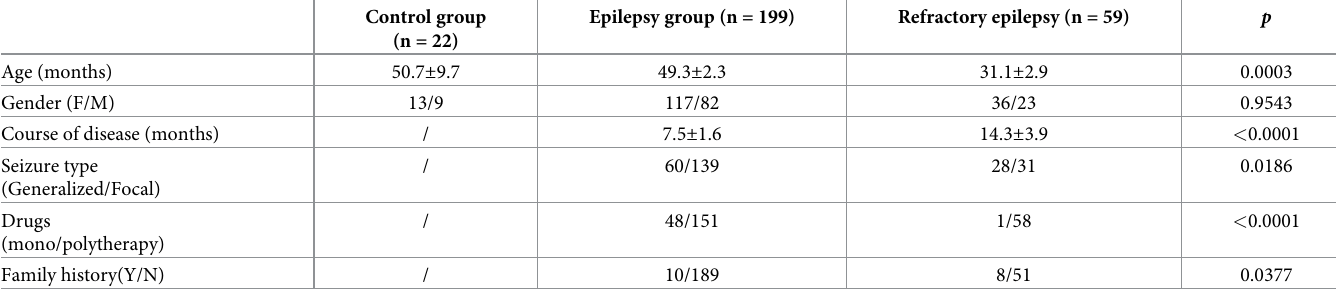
Table 1. Characteristics of the control, epilepsy and refractory epilepsy patients.